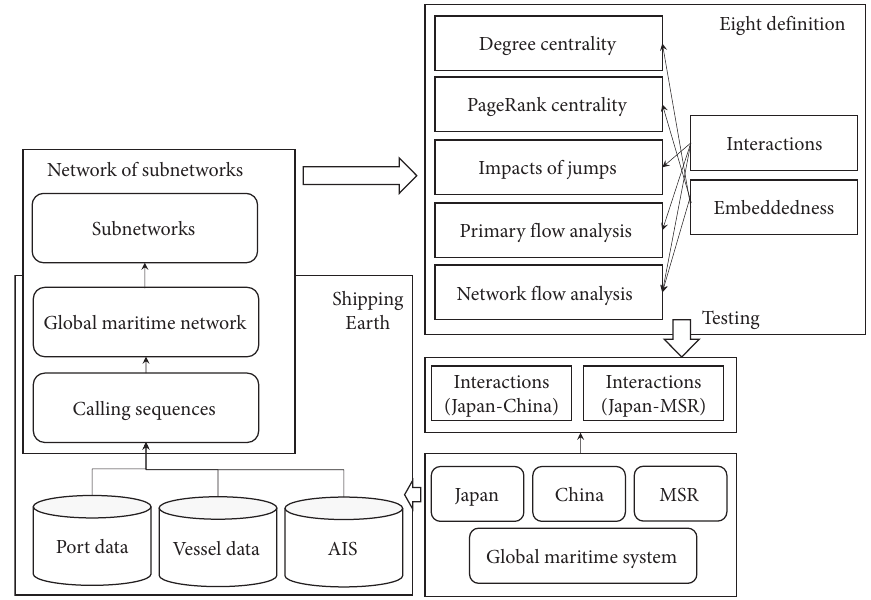
Figure 1: A systematic